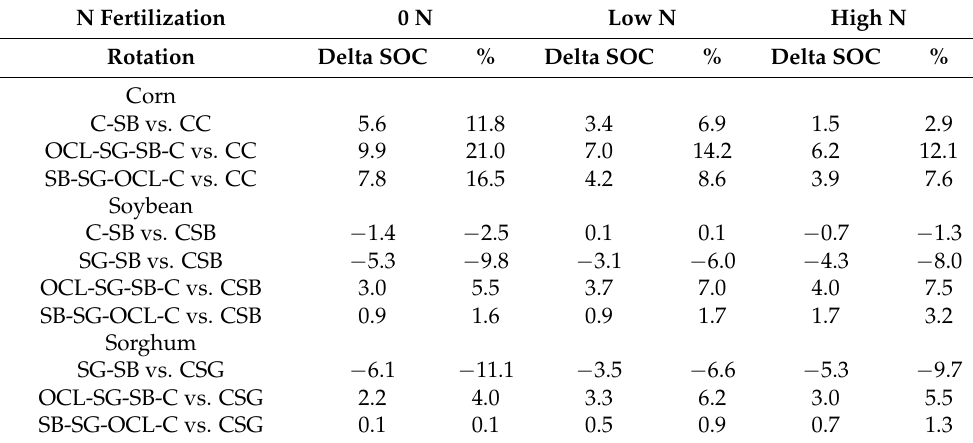
Table 6. SOC comparisons from 2002 for each rotation and N